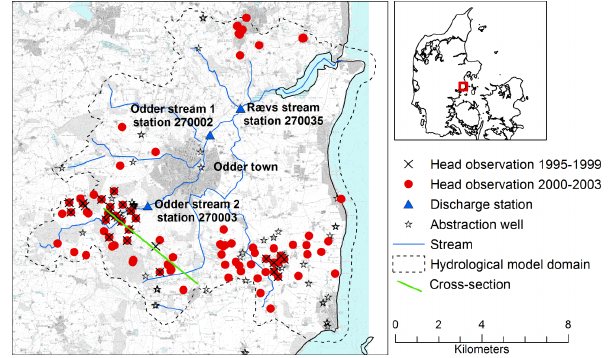
Figure 3. Map of the Norsminde study area. The map shows the lo- cation of the three discharge gauging stations (blue triangles) along the main river, hydraulic head observations for the calibration pe- riod (red dots) and the validation period (black crosses), and ab- straction wells (stars). The black dashed line delineates the model domain of the hydrological